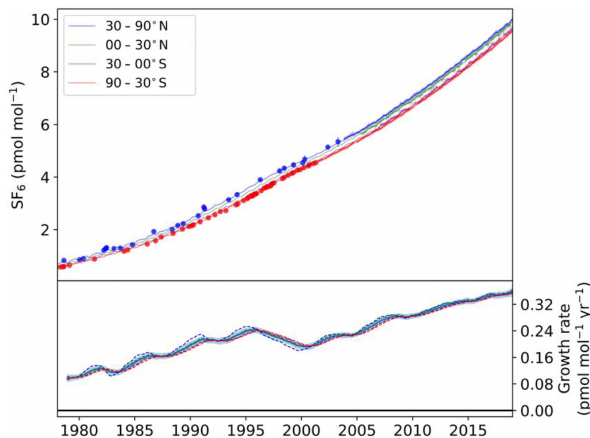
Figure 1. Observed and model-derived SF 6 mole fractions and an- nual growth rates from the AGAGE 12-box model. Upper panel shows measured atmospheric SF 6 mole fractions in each semi- hemisphere (points with 1 σ error bars) and archived air samples collected from 1978 in the NH (blue-filled circles) and archived air samples collected at Cape Grim, Tasmania, in the SH (red-filled cir- cles). Solid lines indicate modelled mole fractions using the mean emissions derived in the global inversion. Semi-hemispheric aver- ages for both the model and data are shown for 30–90 ◦ N (blue), 0–30 ◦ N (green), 30–0 ◦ S (purple), and 90–30 ◦ S (red). The lower panel shows the model-derived growth rate, smoothed with an ap- proximately 1-year filter, for each semi-hemisphere (dotted lines) and the global mean and its 1 σ uncertainty (solid line and shading,